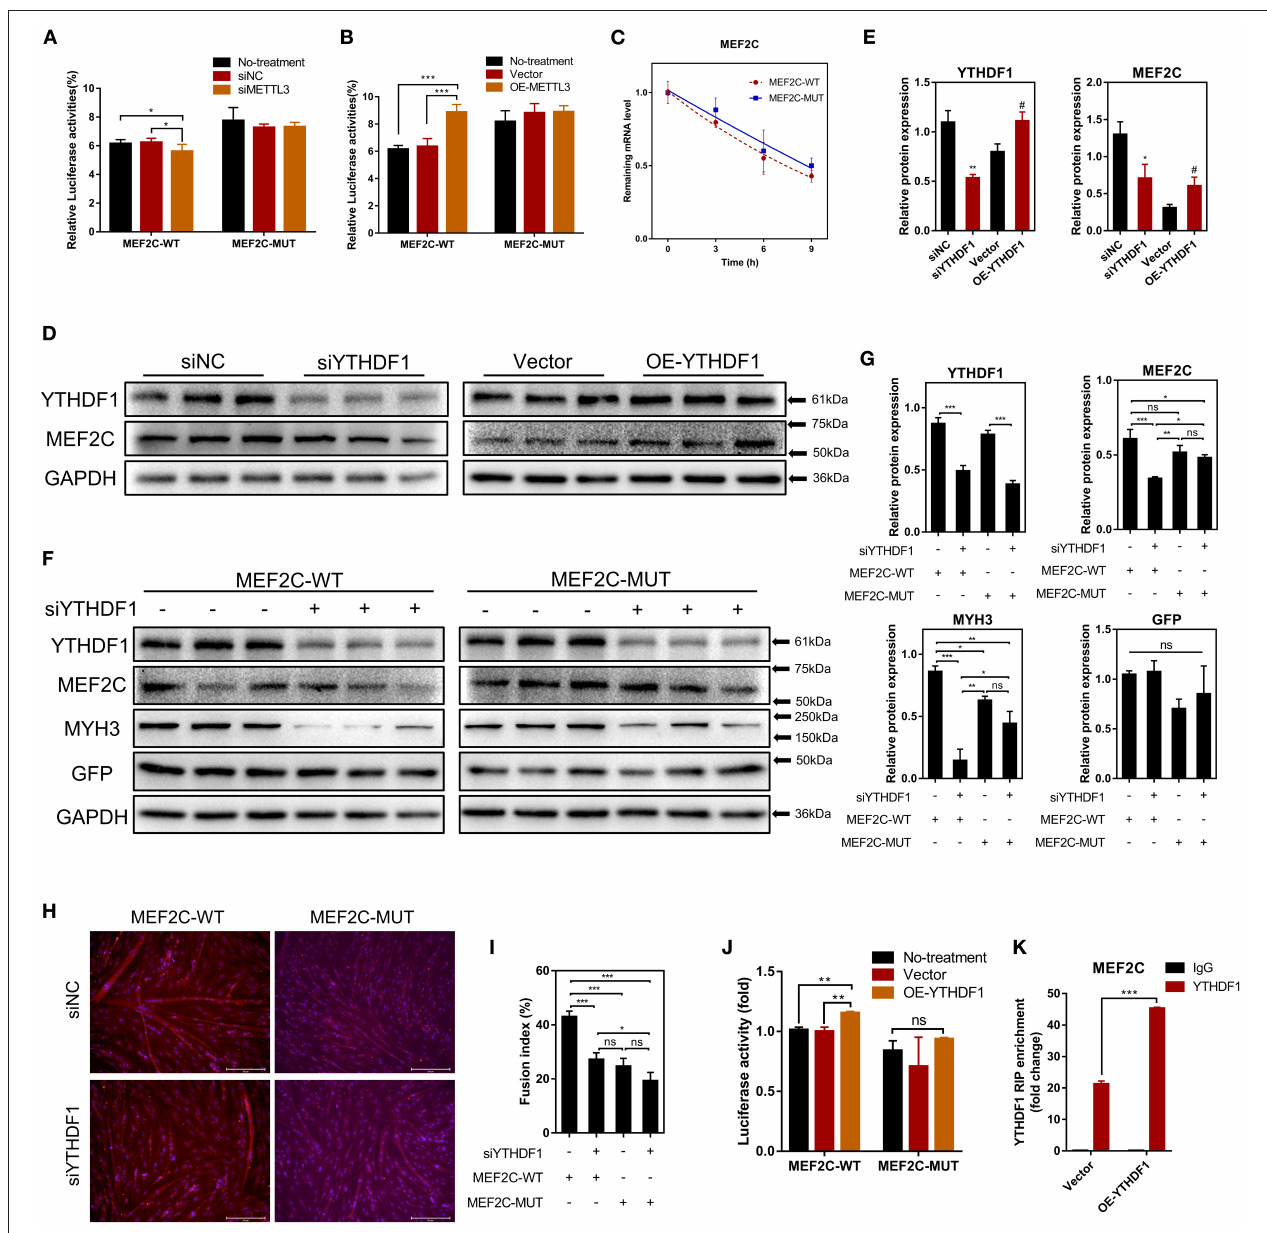
FIGURE 5 | METTL3 increases MEF2C protein expression in an m 6 A-YTHDF1-dependent manner. (A,B) Relative dual-luciferase reporter activity of WT (MEF2C-WT) or mutated (MEF2C-MUT) reporters in METTL3 knockdown or overexpression 293A cells. (C) Representative mRNA profile of MEF2C in MEF2C-WT and MEF2C-MUT myoblasts at indicated time points after actinomycin D treatment. (D,E) MEF2C protein levels after YTHDF1 knockdown and overexpression on the 4th day after differentiation. * p < 0.05, ** p < 0.01, siNC vs. siYTHDF1 samples; # p < 0.05, empty Vector vs. OE-YTHDF1 samples, using Student’s t -test. (F,G) MEF2C, YTHDF1, MYH3, GFP, and GAPDH protein levels in MEF2C-WT or MEF2C-MUT with YTHDF1 expression knocked down after myogenic induction for 4 days. (H) Myotube formation in MEF2C-WT or MEF2C-MUT with YTHDF1 expression knocked down after myogenic induction for 4 days (scale bar: 200 µ m). (I) The fusion index was counted. (J) Relative dual-luciferase reporter activity of MEF2C-WT or MEF2C-MUT reporters in YTHDF1 overexpression 293A cells. (K) RIP-qPCR detection of the binding of YTHDF1 to the transcript of MEF2C in myoblasts transfected with the empty vector and MEF2C-WT. The results are presented as the means ± SD. *** p < 0.001, using Student’s t -test. (A–C,G,I,J) * p < 0.05, ** p < 0.01, *** p < 0.001, ns, no significance, using one-way ANOVA with Tukey’s correction for multiple comparisons. target genes (44, 47). Two potential MEF2C-binding sites